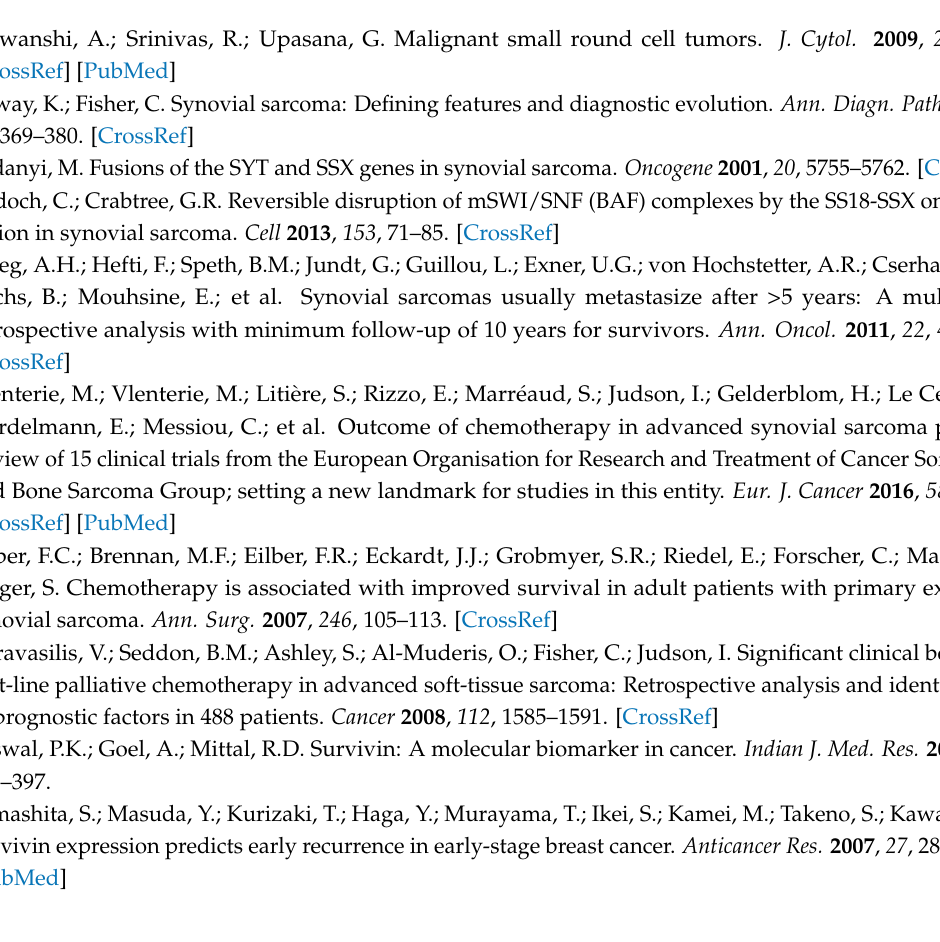
Figure A3. Epigenetic histone marks differ between control and YM155 treated human synovial sarcoma cells, HS-SY-II, at the BIRC5 promoter. ChIP-qPCR for H3K27me3 shows elevated levels at the BIRC5 promoter in the YM155 treated samples compared to controls. ChIP-qPCR for H3K27ac shows elevated levels at the BIRC5 promoter in the YM155 treated samples compared to controls. ChIP-qPCR for H3K4me1 shows a decrease at the BIRC5 promoter in the YM155 treated samples compared to controls.